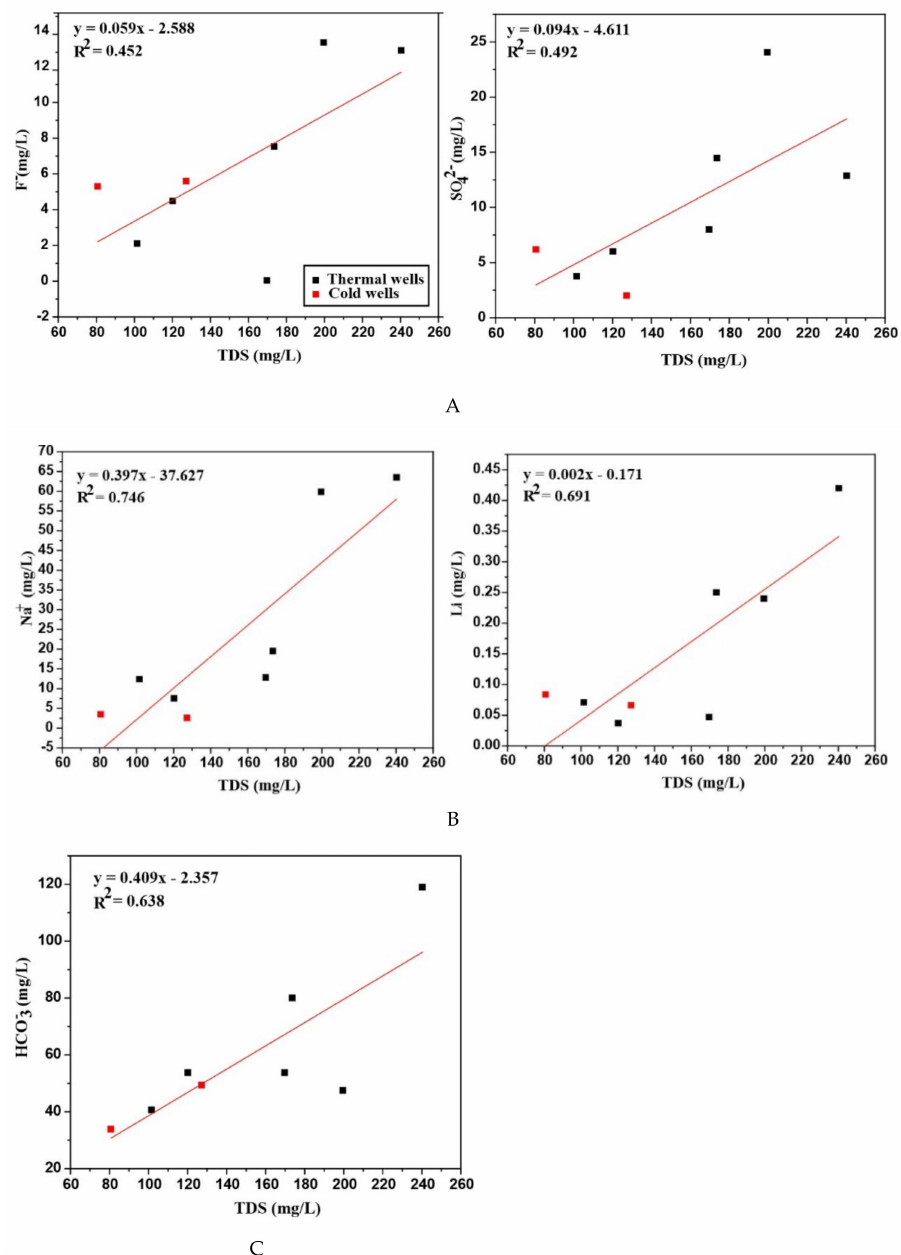
Figure 7. Extent of correlation between TDS and other hydrochemical parameters ( A ) F − , SO 42 − ; ( B ) Na + , Li; ( C ) HCO 3 − ) of thermal and cold ground waters of Suichuan County. Red and black points show the cold and thermal well